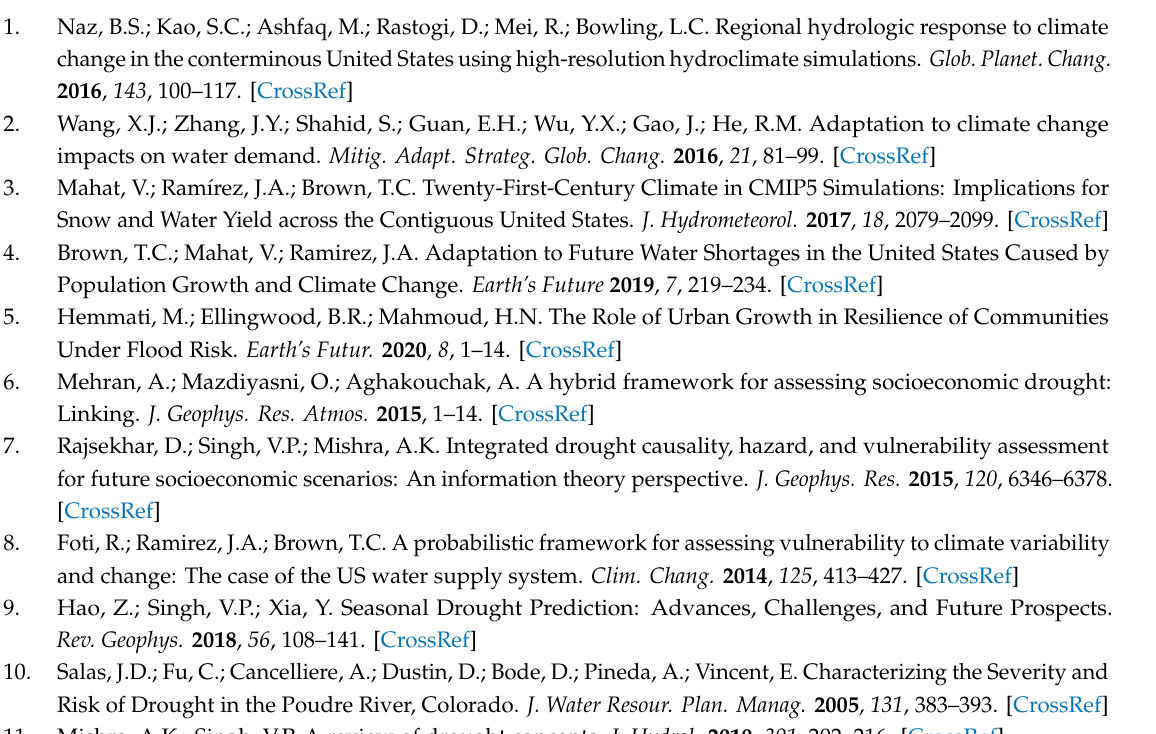
Figure S1: Schematic of Gamma-GPD mixture model; Figure S2: City of Fort Collins, Colorado, USA; Figure S3: Classification of downscaled climate scenarios into hot-dry, hot-wet, warm-dry, warm-wet, and median categories based on the di ff erence in current and future temperature and precipitation; Figure S4: 30-year normal annual precipitation from the current conditions to the future; Figure S5: 30-year normal annual minimum temperature from the current conditions to the future; Figure S6: Mean residual life plot of drought durations; Figure S7: Mean residual life plot of drought intensities, Table S1:Boundaries of mixture model parameters; Table S2: First order sensitivity indices of mixture model parameters; Table S3: Total order sensitivity indices of mixture model